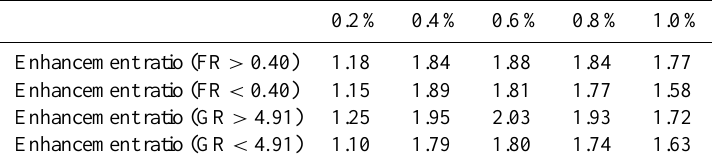
Table 1. Comparison of CCN enhancement ratios from NPF events with different formation and growth rates.